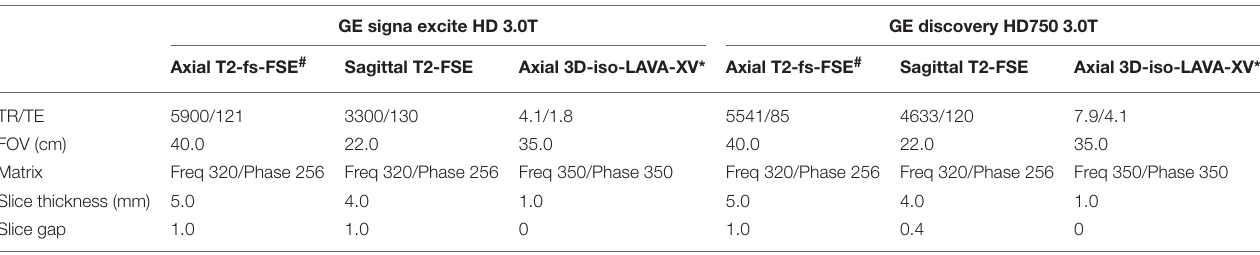
TABLE 2 | Detailed acquired parameters in two MR